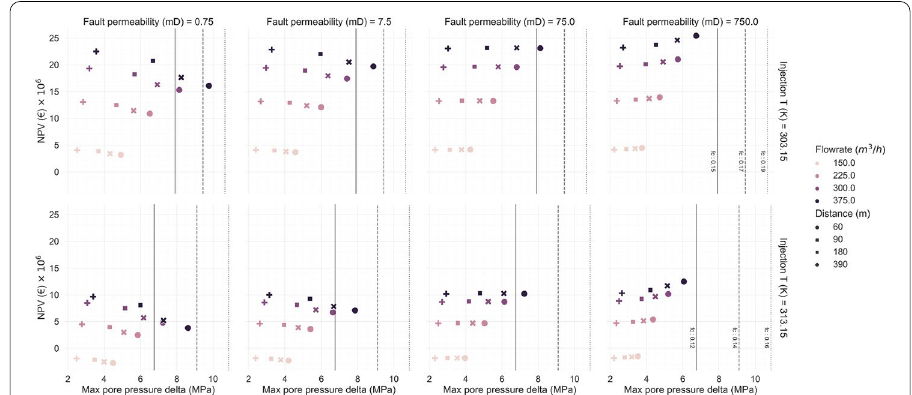
Fig. 13 Combined results for NPV and maximum encountered pore pressure difference as a function of FWD, flowrate and fault permeability. Both the highest and lowest injection temperature are considered. The horizontal lines show the pore pressure for failure-criterion exceedance assuming friction coefficients of 0.15, 0.17, 0.19 and 0.12, 0.14, 0.16 for the injection temperature of 303.15 K and 313.15 K